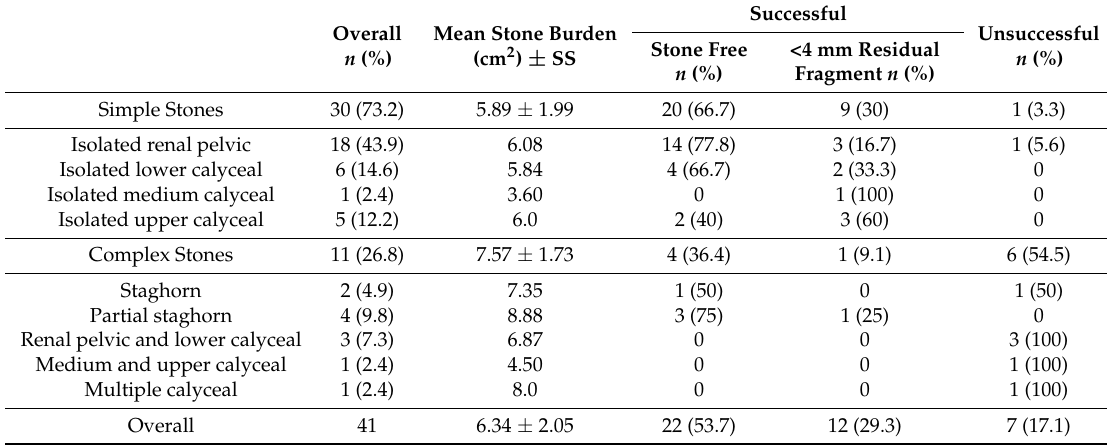
Table 3. Size and success rates of stones according to localizations.